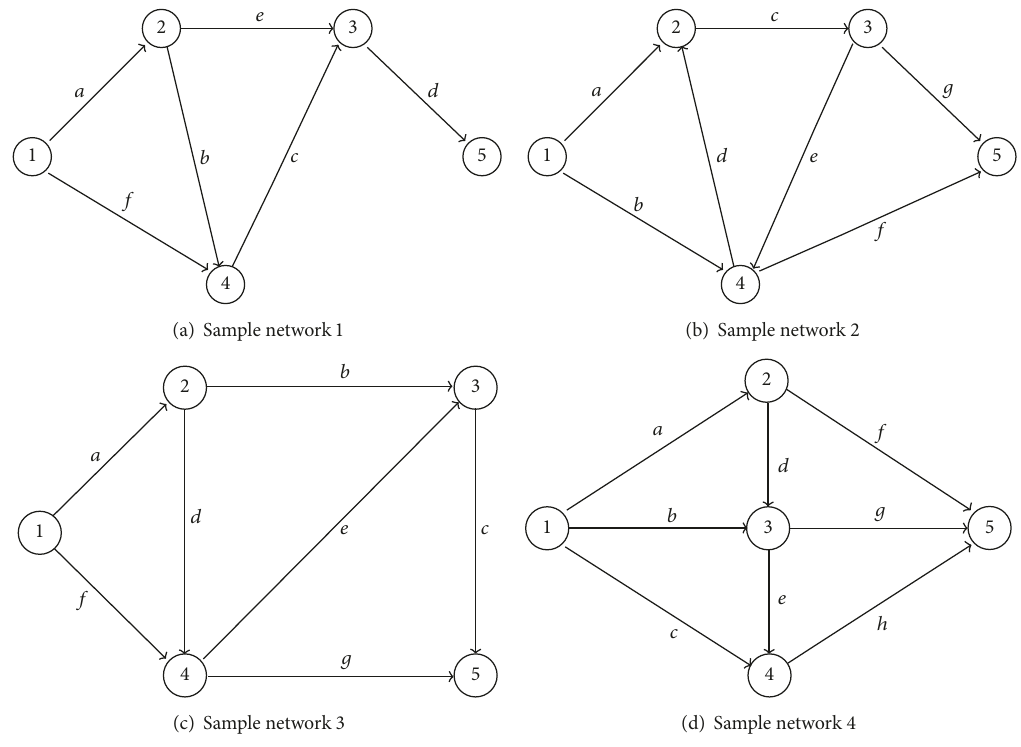
Figure 2: Network